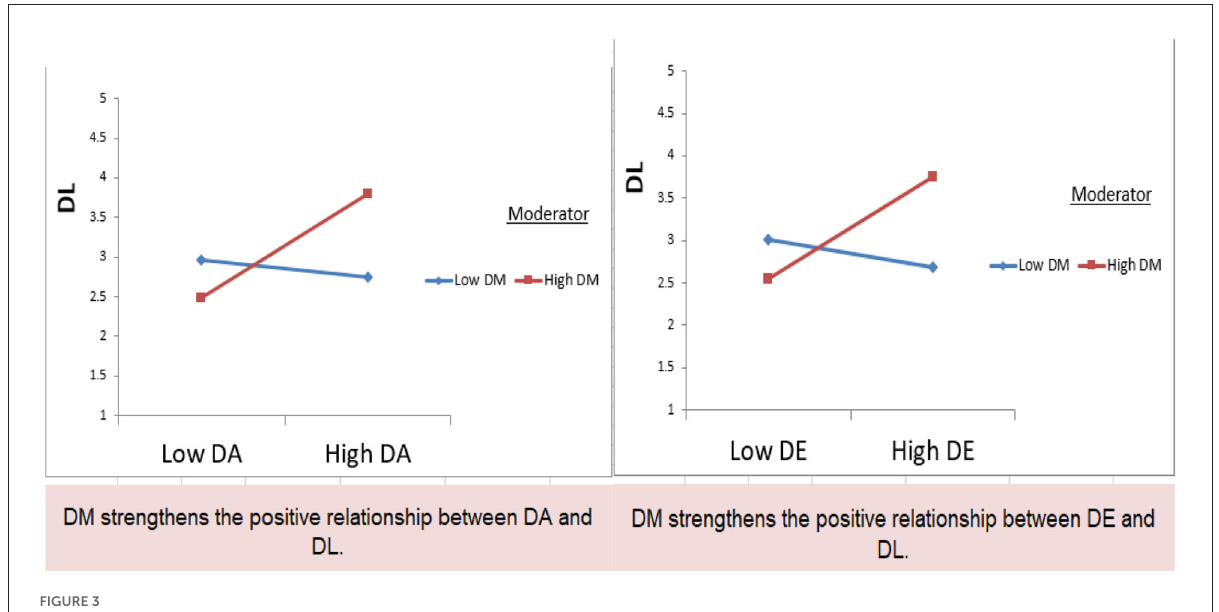
FIGURE3 The graphical interpretation of moderating relationship is